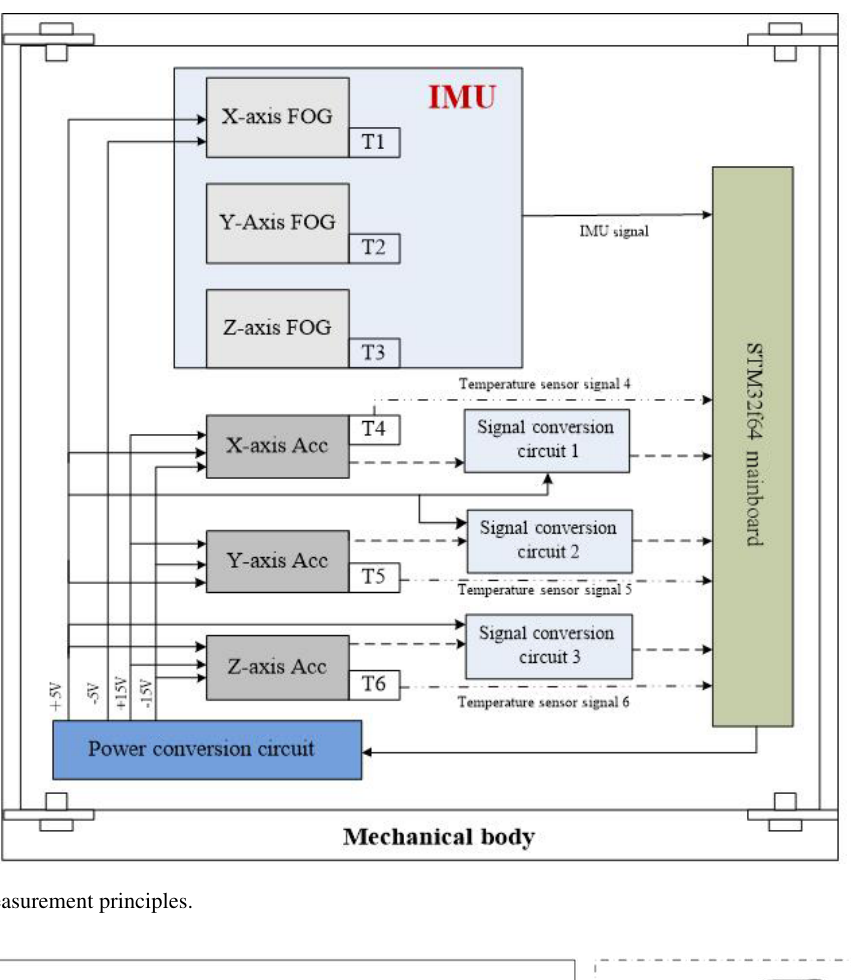
Figure 6. Figure of measurement principles.